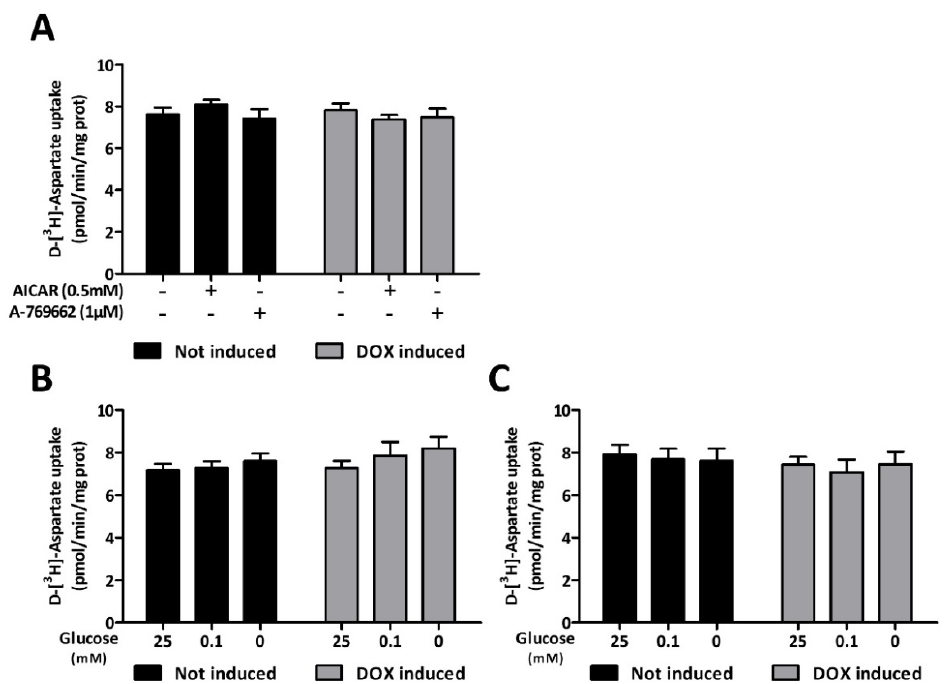
Figure 8. AMPK regulation of glutamate transport. The activity of glutamate transporters was evaluated by measuring the uptake of D -[ 3 H]-aspartate in C6-rtTA-AMPK-DN cells exposed or not to DOX (2 µg/mL; 24 h). ( A ) C6-rtTA-AMPK-DN cells were either treated with the pharmacological AMPK activators AICAR (0.5 mM) and A-769662 (1 µM) for 3 h, or ( B , C ) exposed to glucose deprivation conditions for 3 and 6 h. Histograms show means ± SEM of data obtained from three independent experiments performed in quadruplicate. Statistical analyses were performed by two-way ANOVA followed by Bonferroni’s multiple comparison test.